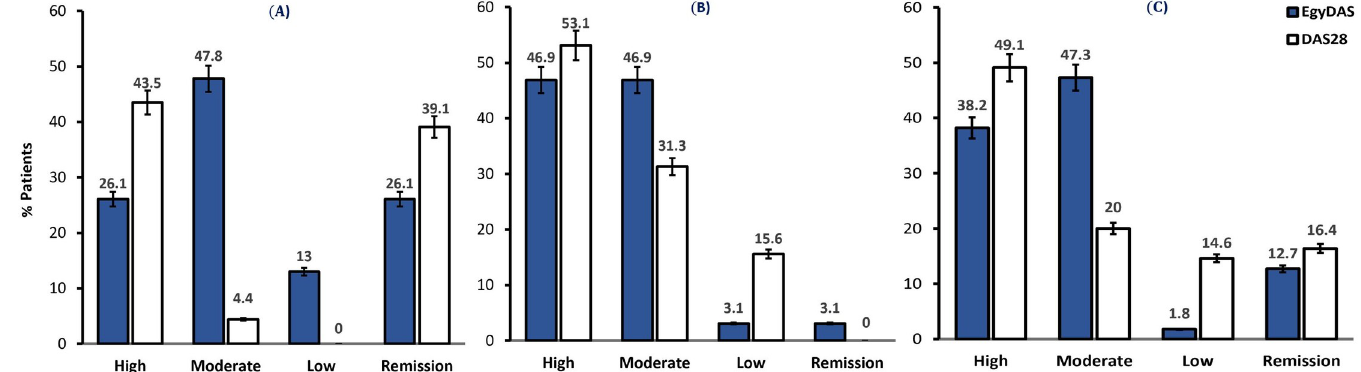
Fig 1. Distribution of rheumatoid arthritis disease activity categories for EgyDAS and DAS28 scores. ( A ) Distribution of the control group of 23 patients. ( B ) Distribution of the ankle involvement group of 32 patients, ( C ) Distribution of all the data of the 55 patients.